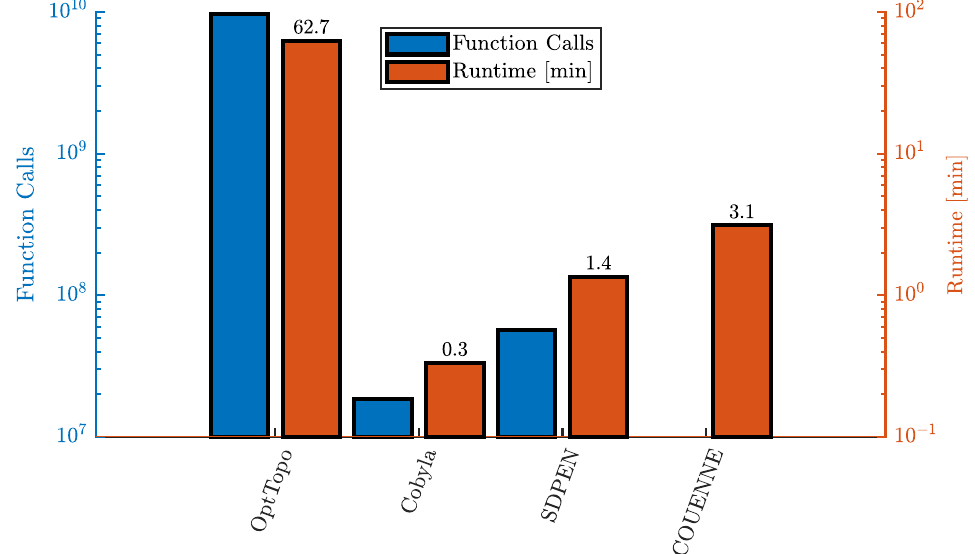
Figure 5. The runtime of the optimizers in comparison: The logarithmic scale allows a better illustration. OptTopo is by far slower than the